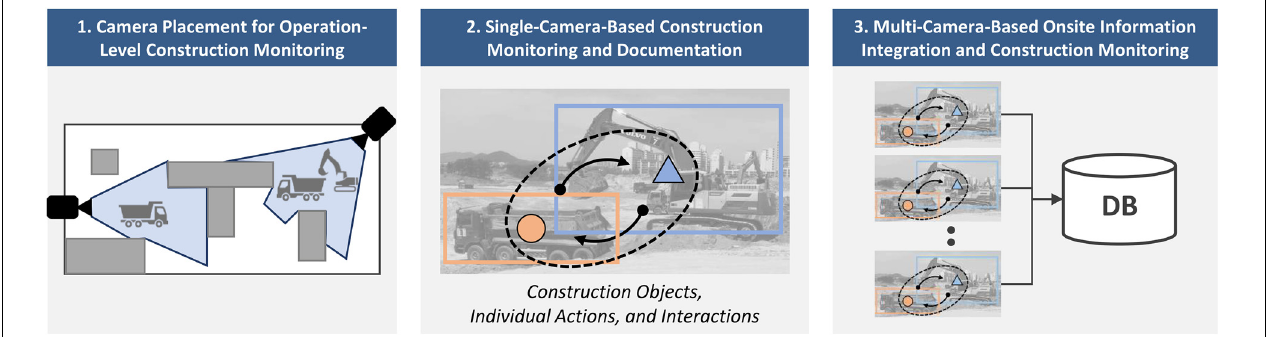
FIGURE 2 | Technologies of operation-level construction monitoring and